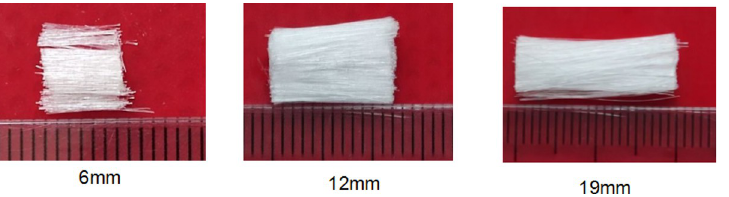
Fig 3. The fibers used for the study. The fibers used for the study is polypropylene monofilament staple fibers, which have high strength and elastic modulus, excellent dispersion, no agglomeration, stable chemical properties, acid and alkali